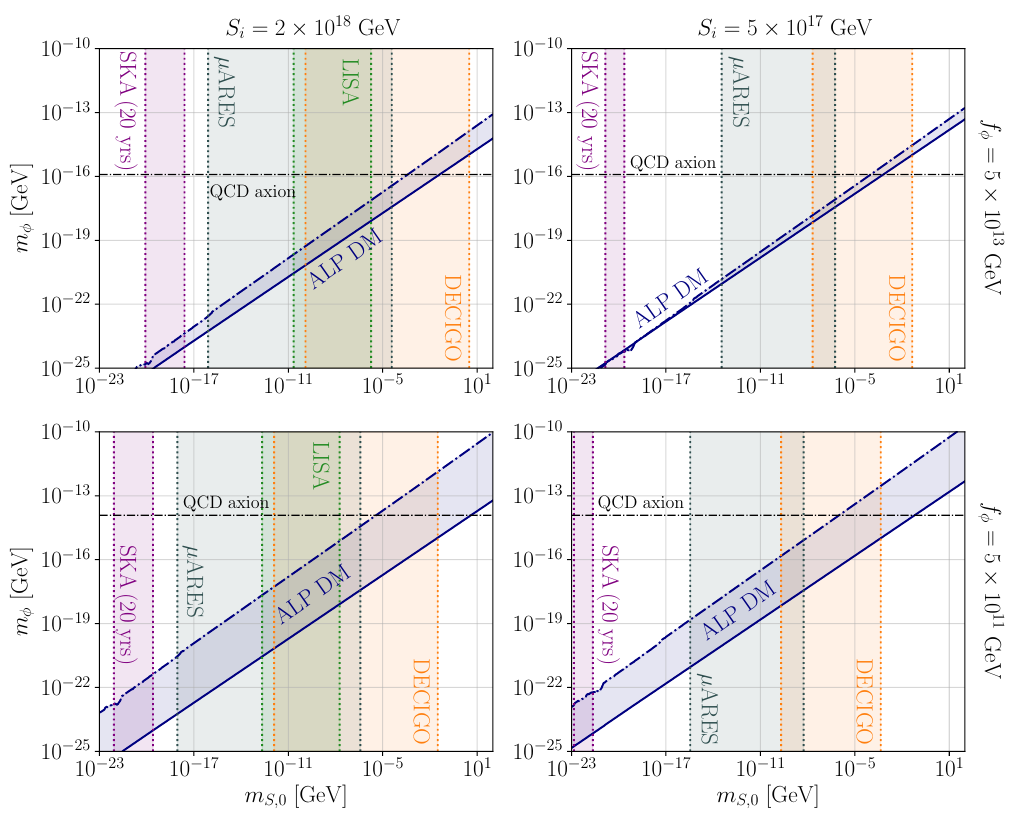
Figure 9: Parameter region in the m φ − m where the ALP has the correct relic abun- S dance to constitute DM for a benchmark coupling of α = 0.1. The blue band rep- resents the maximum and minimum abundance limits computed in Sec. 5.1. Here, we choose two different benchmark values for f φ and S . The colored bands show i the sensitive regions of several projected GW experiments. Clearly, the width of the detection bands does not change when altering f φ , hence detectable GWs are pro- duced over the entire range of ALP decay constants, provided S is sufficiently large. i In addition, we find a mass configuration for every detectable signal that gives the correct relic abundance for the ALP to constitute